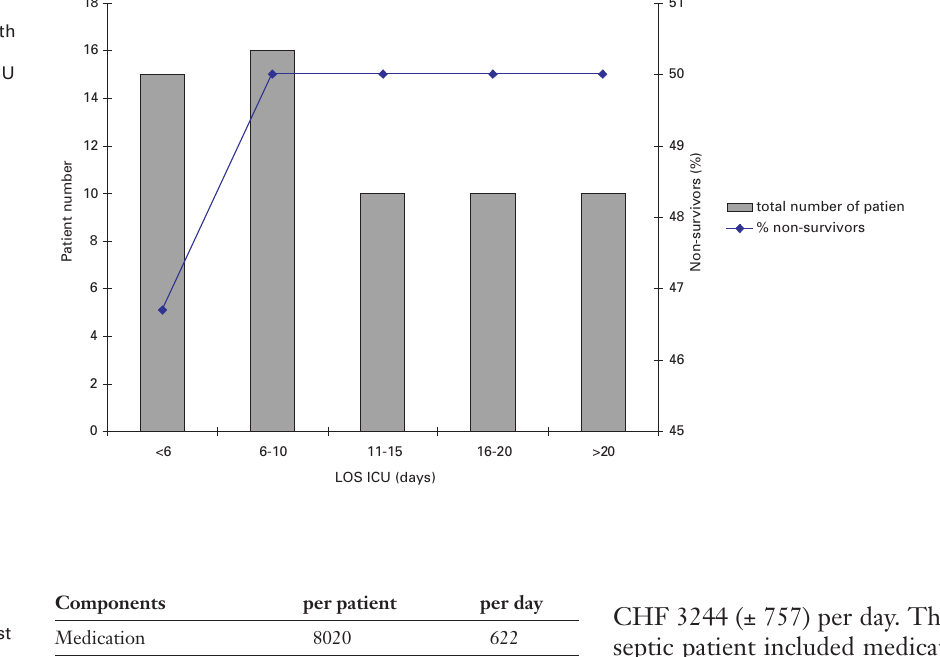
Mean direct ICU cost per severely septic patient and per day (in CHF).